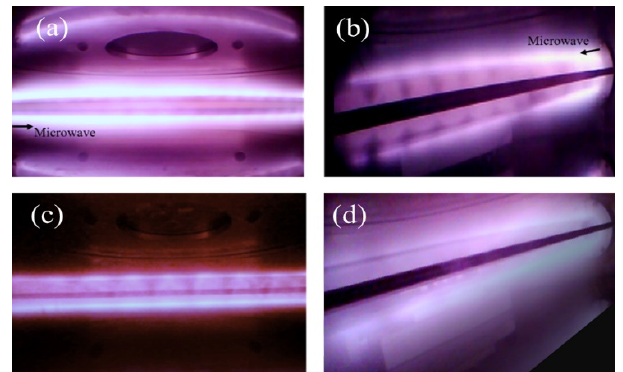
Figure 7. Images of MWP plasma optical emission patterns of Ar circular TE 11 waveguiding structure. ( a ) Front view, ( b ) right side view, quasi-coaxial TEM, ( c ) front view, and ( d ) right side view .